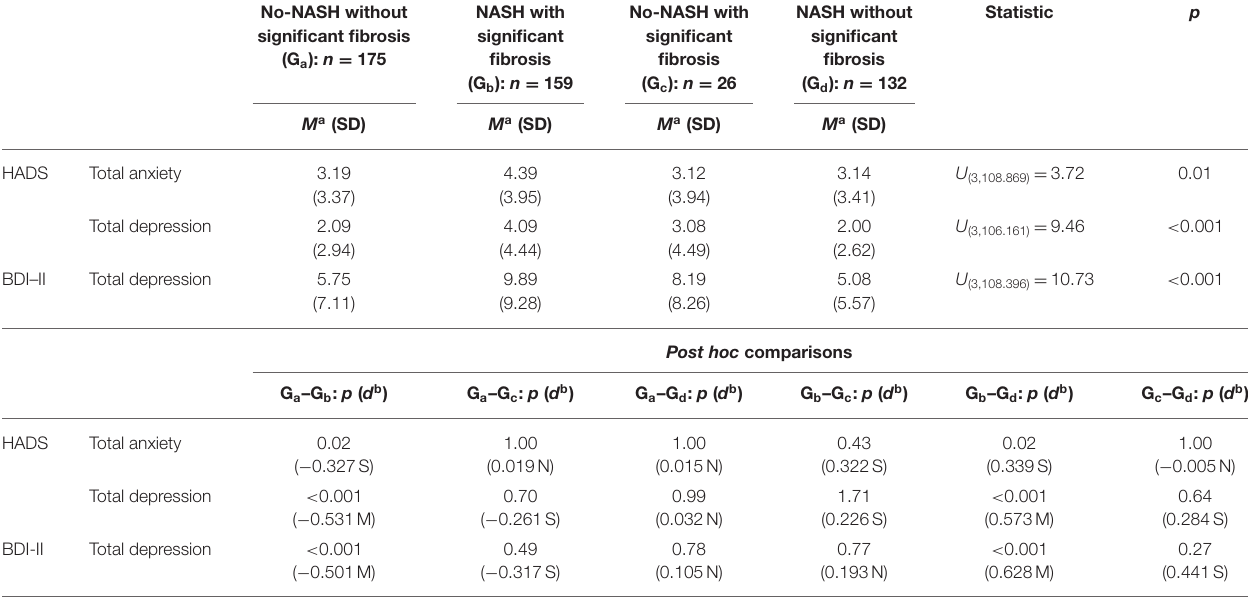
TABLE 8 | Comparison of mental health (HADS and BDI-II) between non-alcoholic fatty liver disease (NAFLD) severity groups: non-alcoholic steatohepatitis (NASH; with and without significant fibrosis) and no-NASH (with and without significant fibrosis). No-NASH without significant